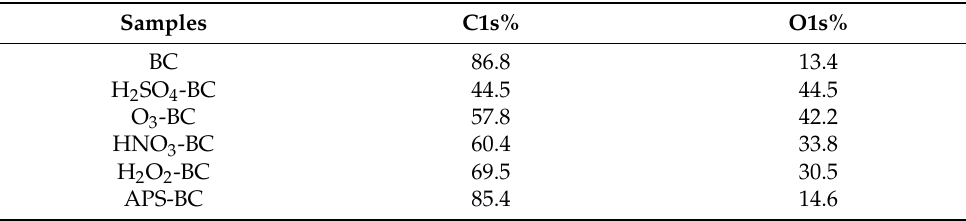
Table 4. Atomic composition of pristine and oxygen-enriched biochar